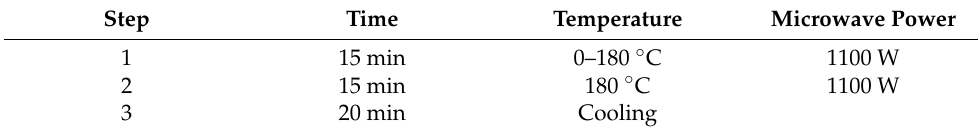
Table 1. Operative conditions for the microwave oven digestion.